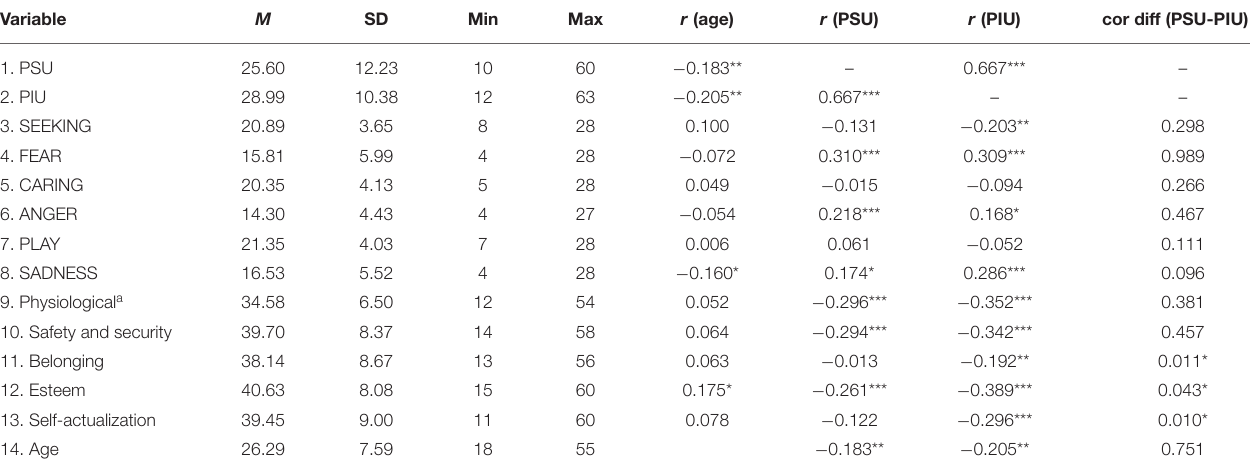
TABLE 1 | Descriptive statistics and Spearman correlation analysis results.